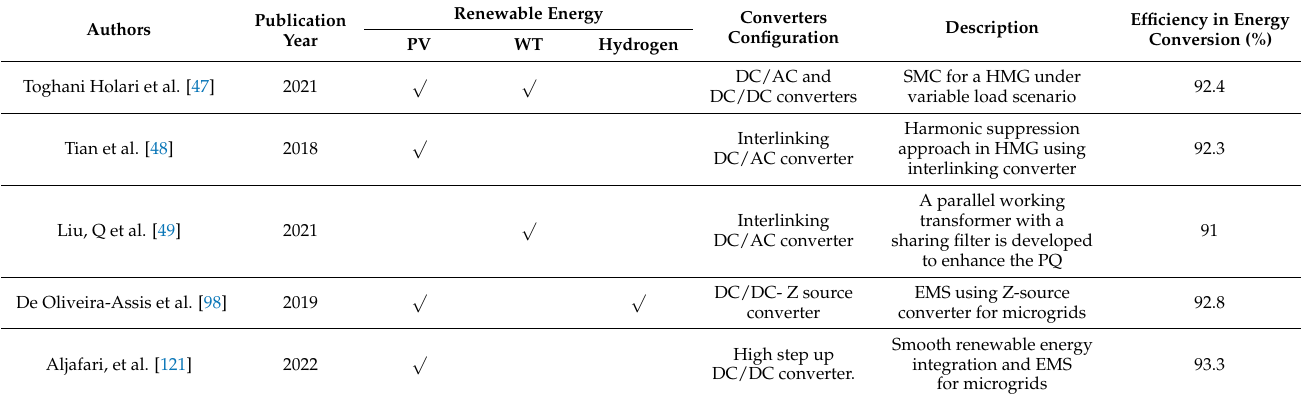
Table 4. Comparison of renewable energy integration and multi energy conversions in